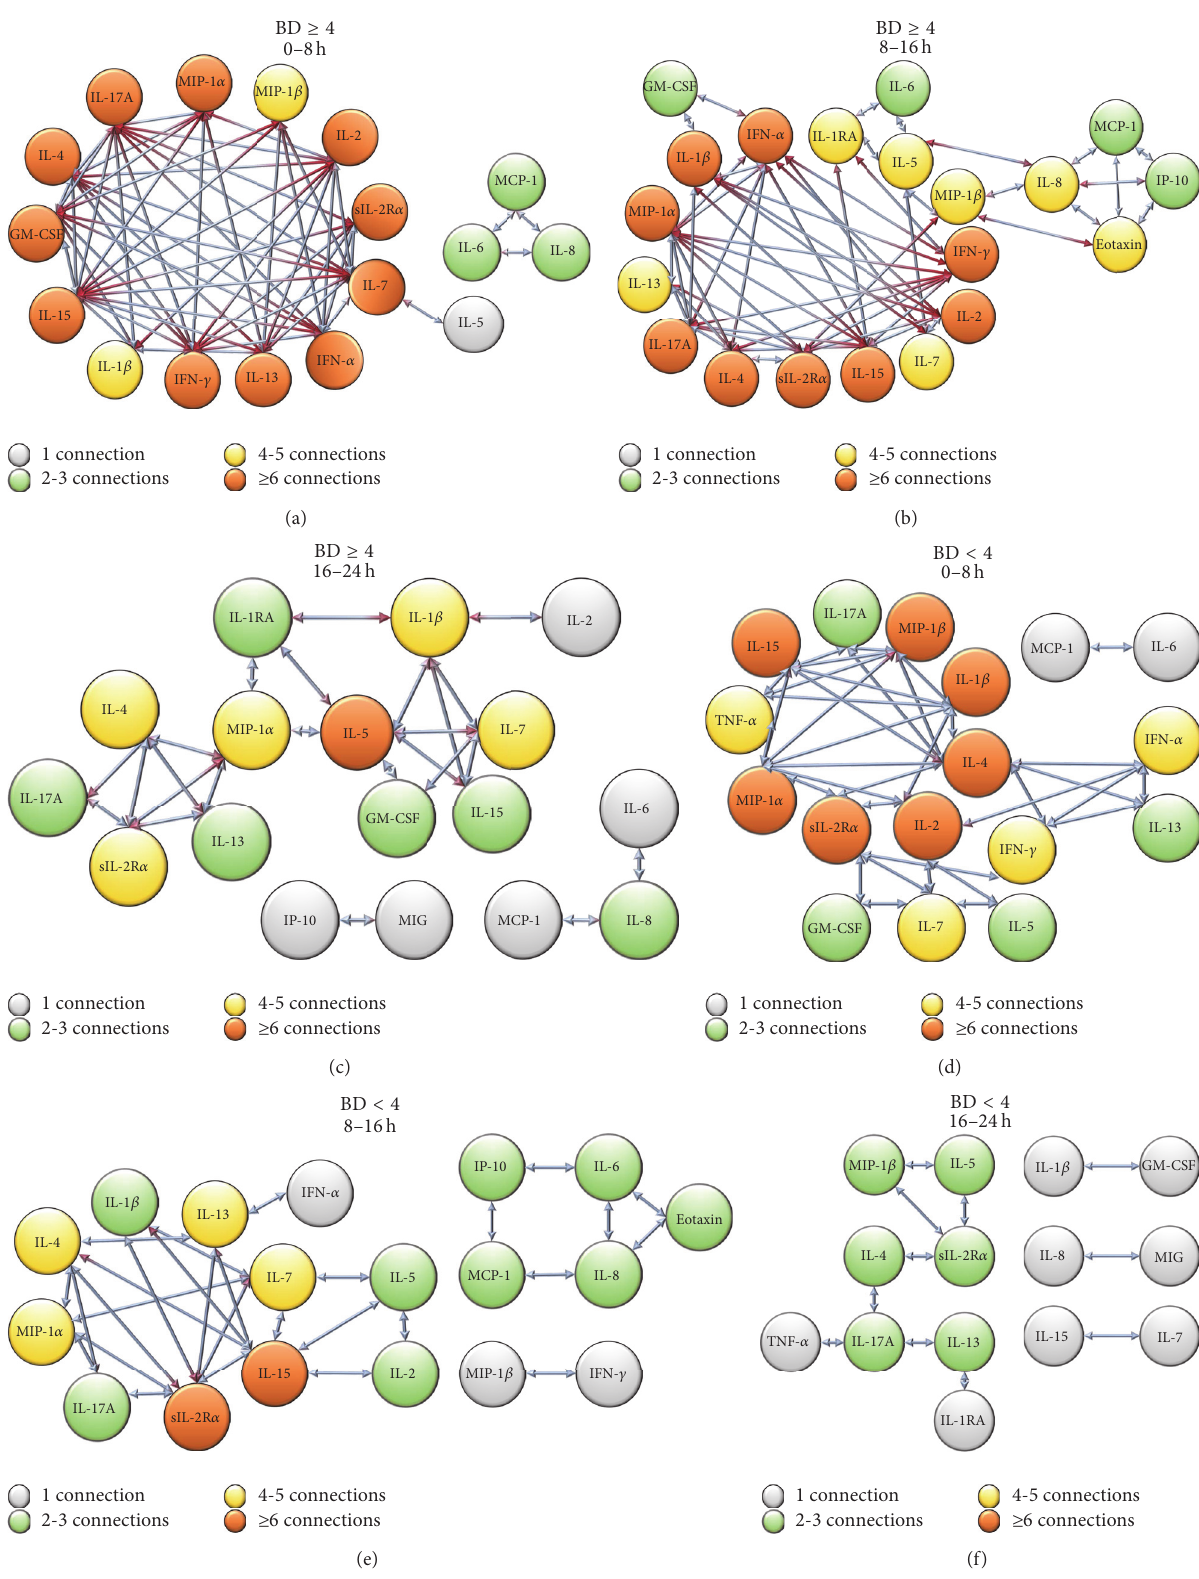
Figure 5: Dynamic network analysis (DyNA) of inflammatory mediators in BD ≥ 4 and BD < 4 subgroups suggests an early differential network connectivity within 16h after injury. DyNA at 0–8 h suggested that IFN- 𝛼 /sIL-2R 𝛼 /MIP-1 𝛼 /IL-17A/IL-4/GM-CSF/IL-7/IL-2/IFN- 𝛾 /IL-13 were highly connected in the BD ≥ 4 group (a) while the BD < 4 group (d) exhibited a lesser degree of connected nodes: MIP-1 𝛼 /sIL- 2R 𝛼 /MIP-1 𝛽 /IL-4/IL-1 𝛽 /IL-2/IL-15. DyNA at 8–16h suggested that the BD ≥ 4 group (b) retained the connectivity among inflammatory mediators, whereas the BD < 4 group (e) continued to exhibit a lesser degree of connections. DyNA at 16–24 h suggested that the BD ≥ 4 group (c) exhibited a substantial reduction of network connectivity to a level similar to BD < 4 group